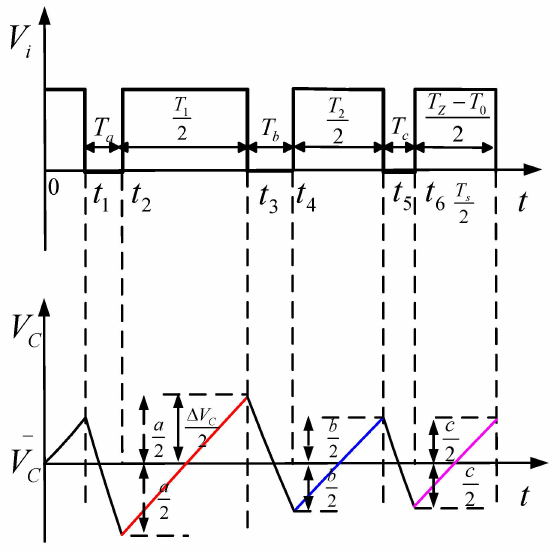
Figure 7. Diagram of Z-source capacitor voltage ripple with improved PWM